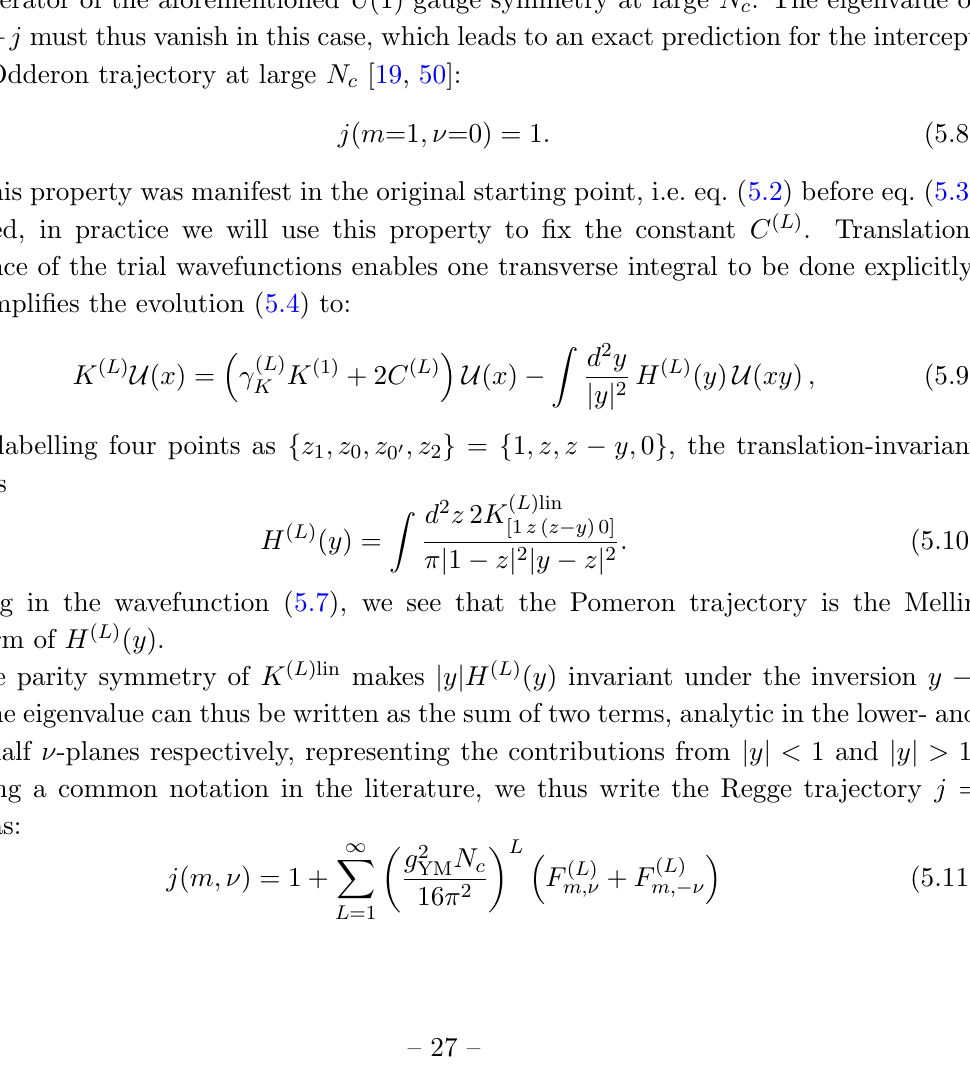
(cid:0) z ) = z (cid:0) z , corresponding to m = 1 and (cid:23) = 0, i j i j